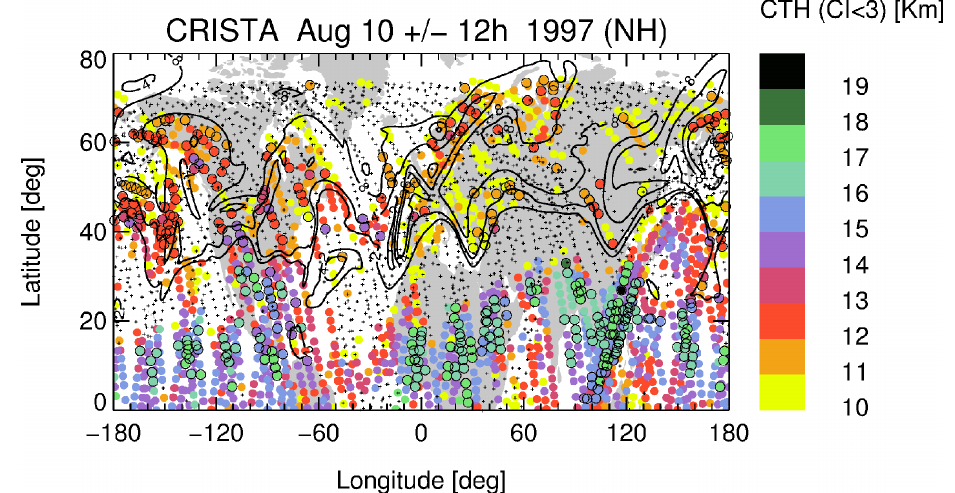
Figure 1. CRISTA cloud top height distribution for 10 August 1997 at 10 00:00 UTC ± 12h (coloured circles). Profiles with no cloud indications are marked by black crosses. Overlaid in black are contours of potential vorticity at 2, 4, and 8 PVU at the 350K isentrope. Cloud tops with PV values greater than the proxy threshold 2 PVU for the dynamical tropopause are highlighted by black borders around the coloured circles for CTH (cloud top height).